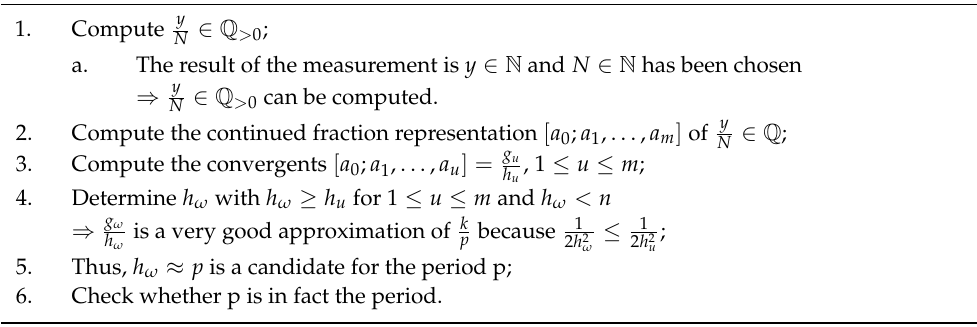
Algorithm 2 Determining with probability of approximately 4/ π 2 the period p we are looking